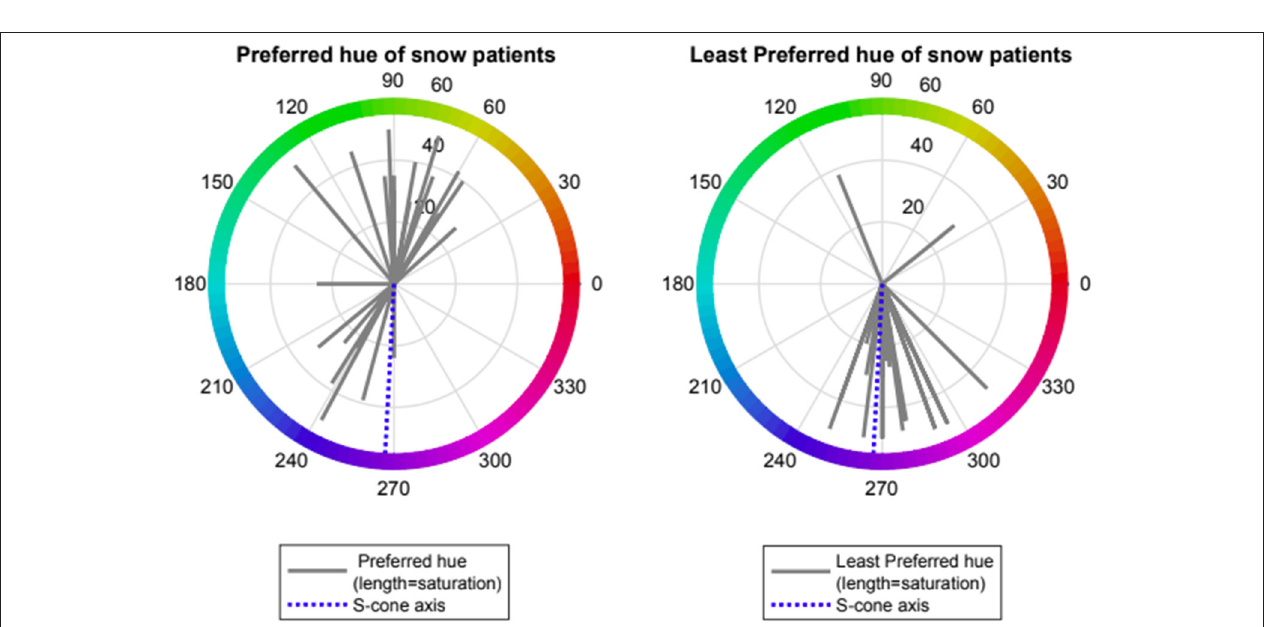
FIGURE 2 | Preferred and Least preferred hue of visual snow participants expressed as angle in CIE 1976 LUV space (red lines); dotted blue line represents the Tritanopic confusion line (S-cone axis).